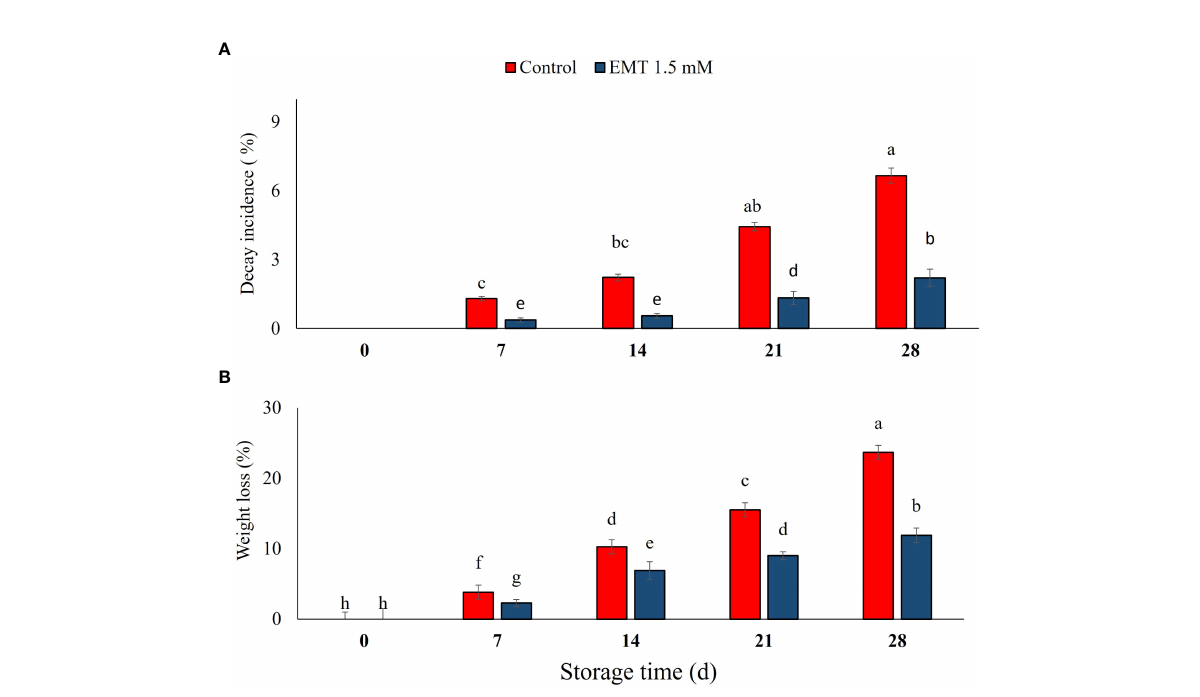
FIGURE 1 Effect of exogenous melatonin (EMT) treatment on fruit decay (A) and weight loss (B) of papaya fruits during cold storage. Data collected from the mean of three replicates, and vertical bars indicate the standard error of the means. Mean values with different letters show signi fi cant differences, and those with similar letters show no statistical difference according to the least signi fi cant difference test ( P <